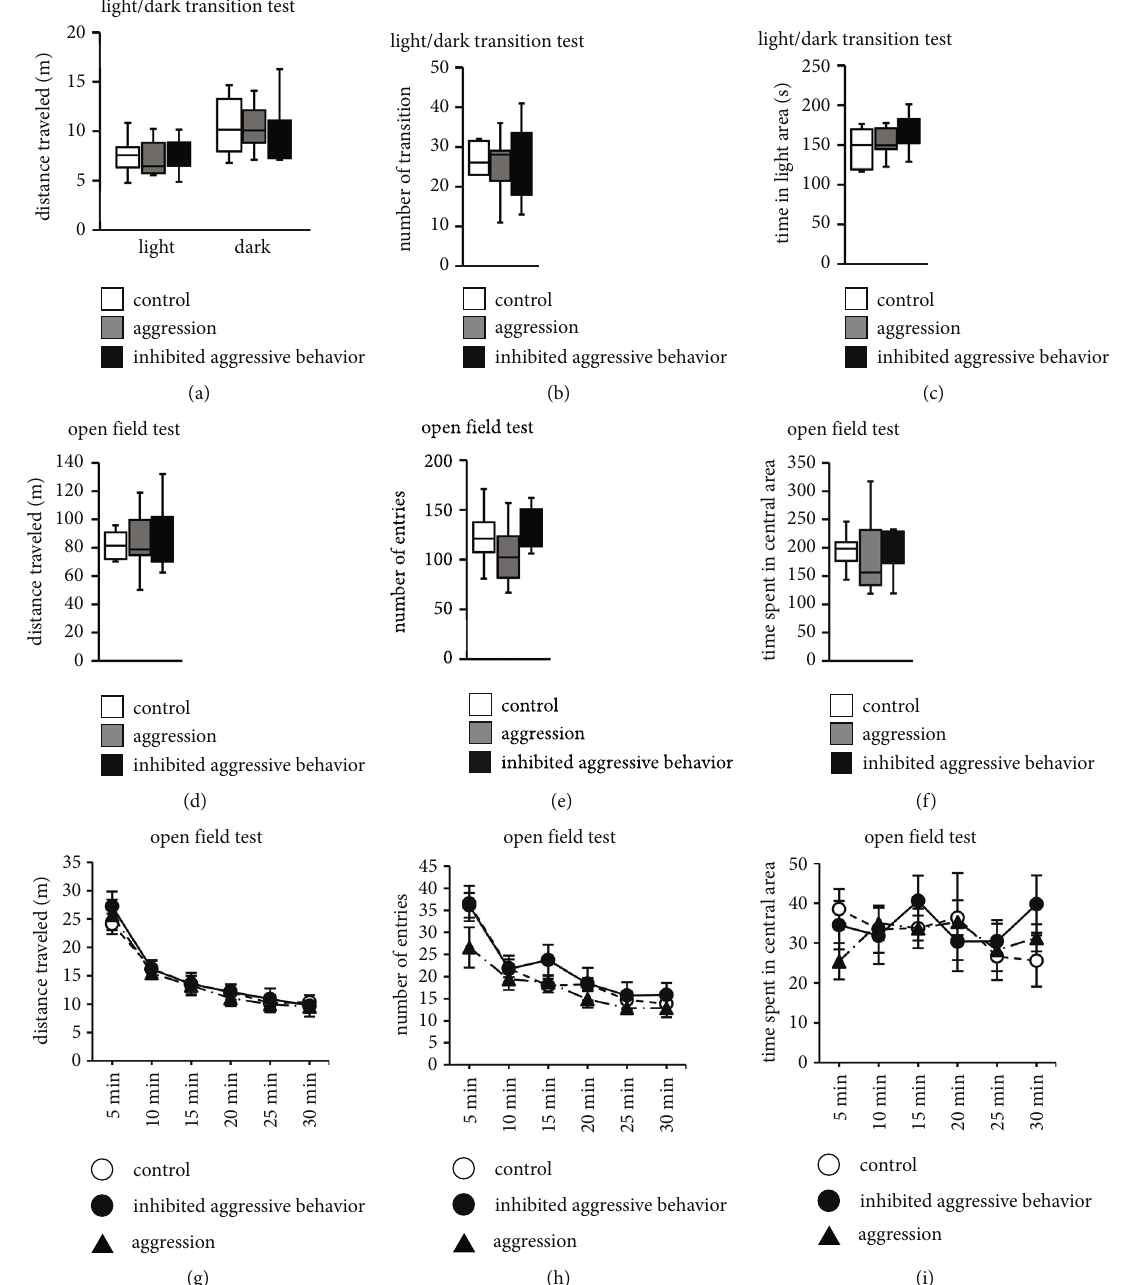
Figure 3: Performance of aggressive behavior-inhibited mice in the light/dark transition test and open fi eld test. Total distance traveled (a), number of light/dark transitions (b), and time spent in the light area (c). Total distance traveled (d), number of entries into the central area (e), and total time spent in the central area (f). Graphs show the distance traveled (g), number of entries into the central area (h), and time spent in the central area (i) in each of the 5-minute test periods. Data are presented as box plots (a) – (f). * p < 0 : 05 and + p < 0 : 1 . (a) – (i) Control group: n = 7 , aggression group: n = 7 , and inhibited aggressive behavior group: n = 7